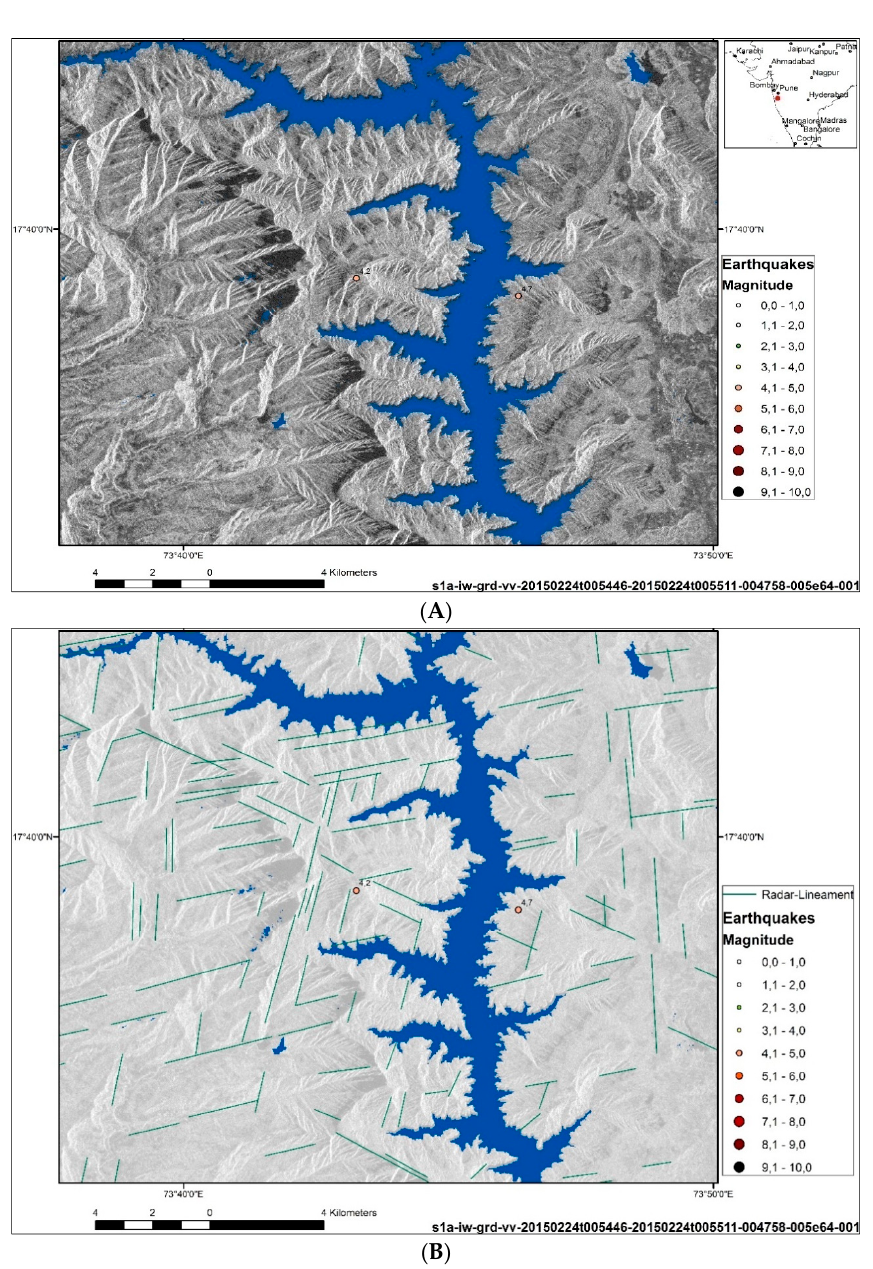
Figure 14. Linear features (green lines) mapped based on the Sentinel radar image ( A ) in the area of the Koyna reservoir ( B ).